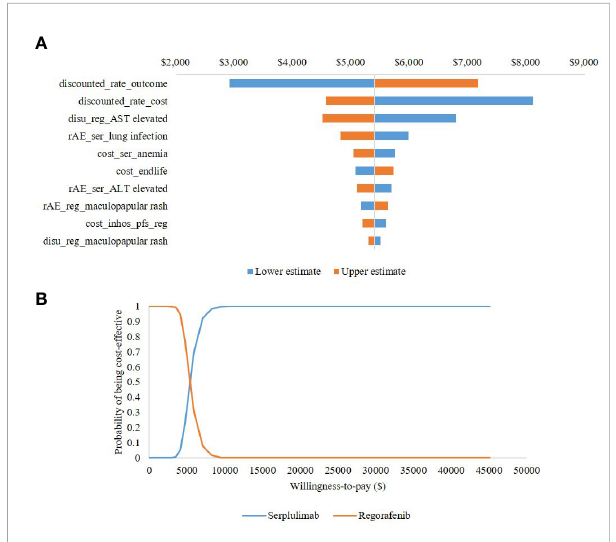
FIGURE 3 Uncertainty analysis results (A) presents tornado diagram of